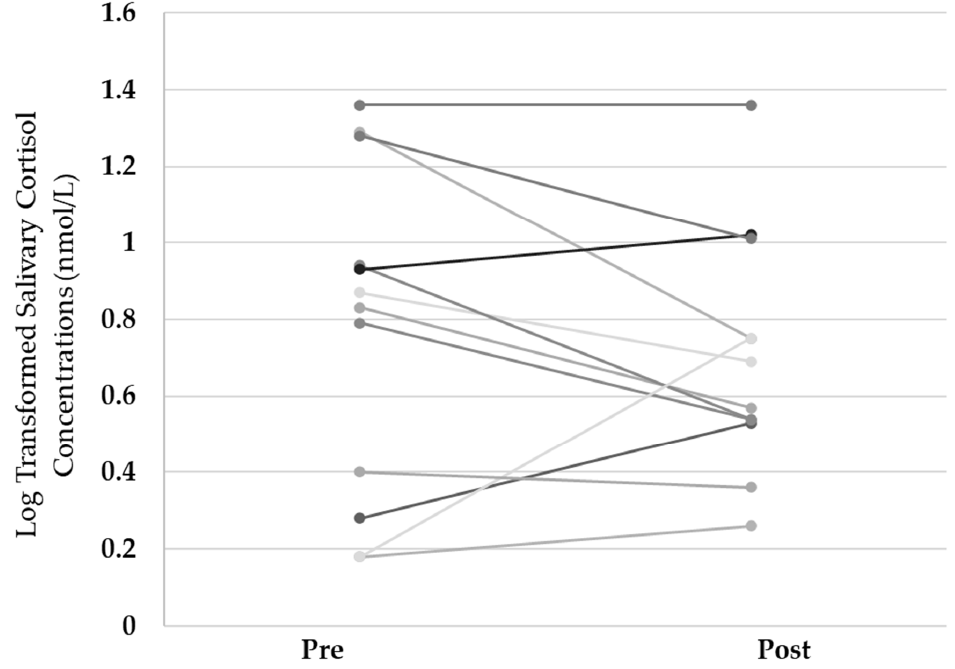
Figure A4. Plot showing changes in salivary cortisol concentrations pre- and post-participation in summer goose harvesting activities.